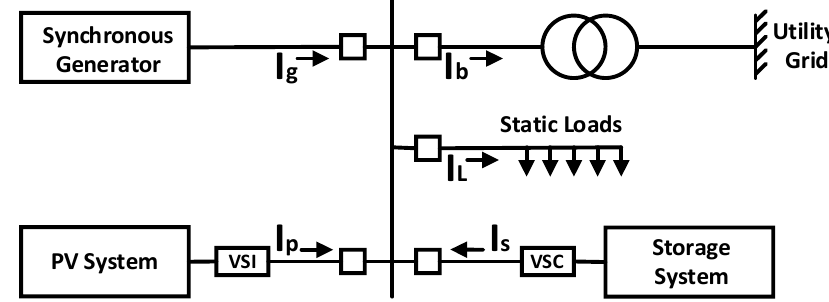
Figure 1. Single line diagram of the microgrid (MG) system.